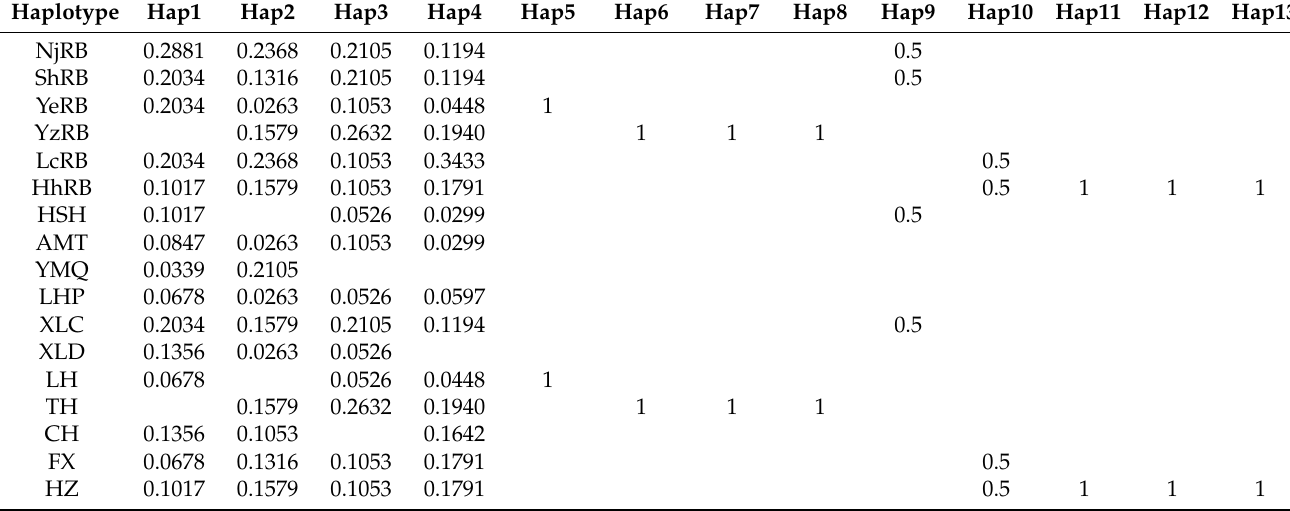
Table A2. Frequency in each population and basin of COI gene haplotypes in N.